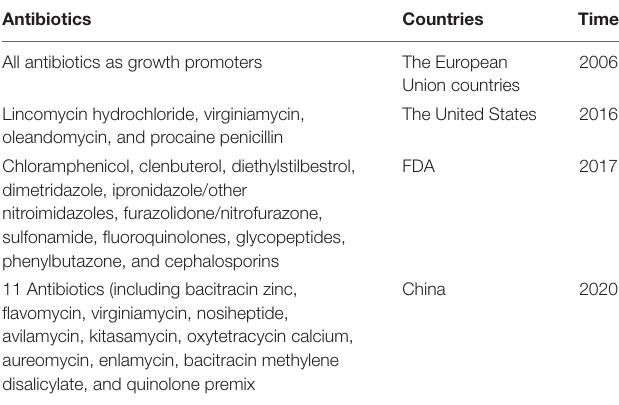
TABLE 4 | Some antibiotics prohibited from use in food